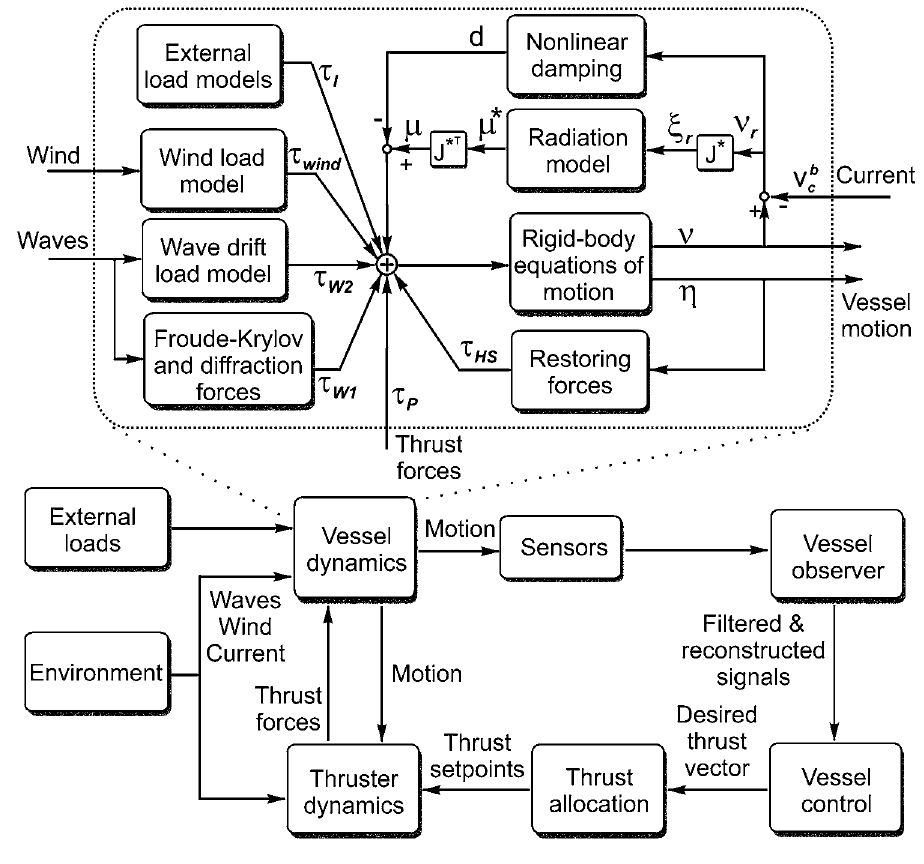
Figure 3. Marine system